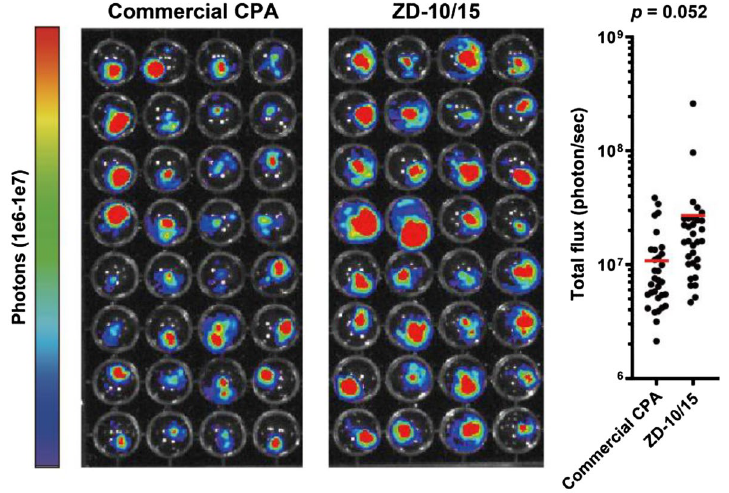
Figure 4. The relative number of living cells in cryopreserved mouse tumor tissues post-thaw using commercial CPA and ZD-10/15. Each tumor explant was quantified with IVIS and plotted. The commercial CPA employed was Cell Reservoir One (Nacalai Tesque).